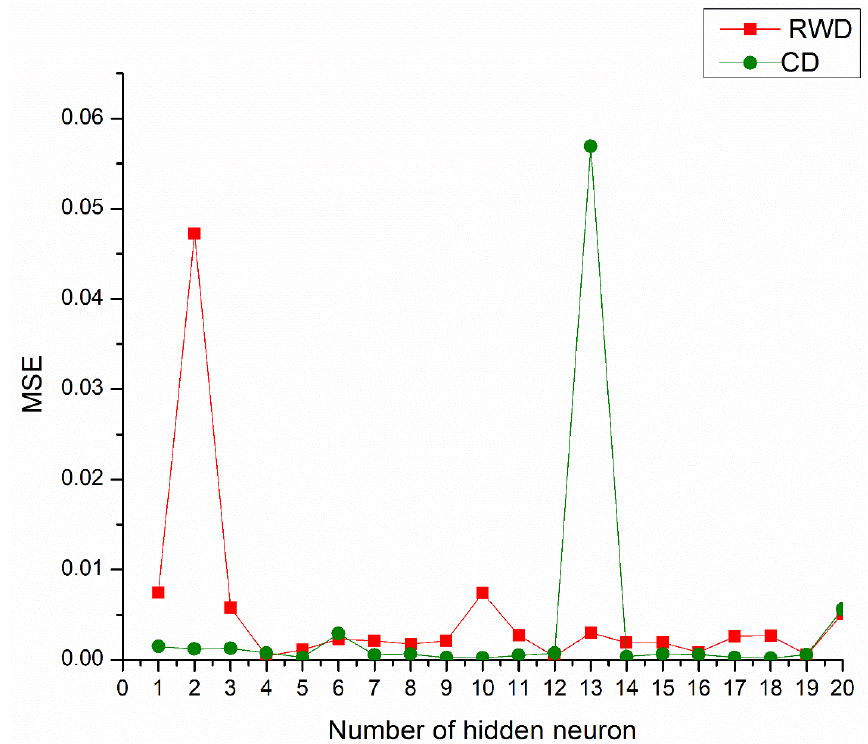
Figure 4. Performance evaluation of the ANN model.